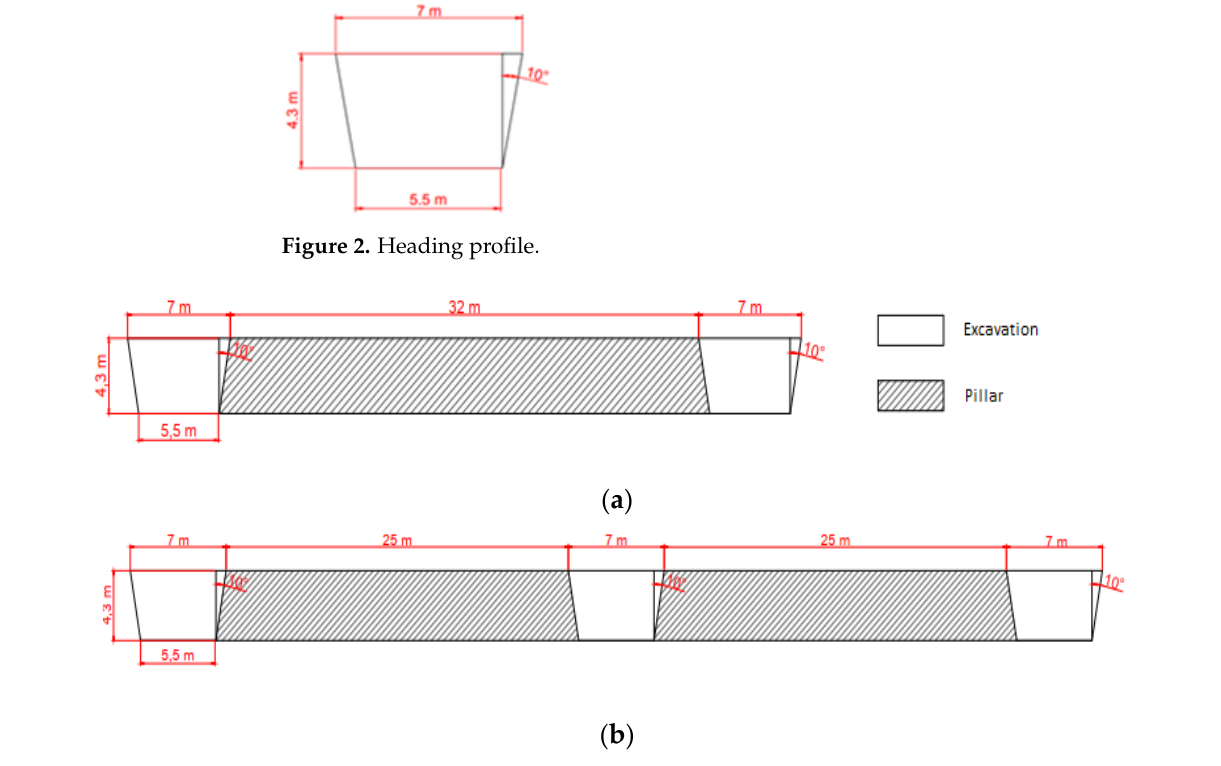
Figure 3. ( a ) Cross-section through the ramps; ( b ) cross-section through the entries.